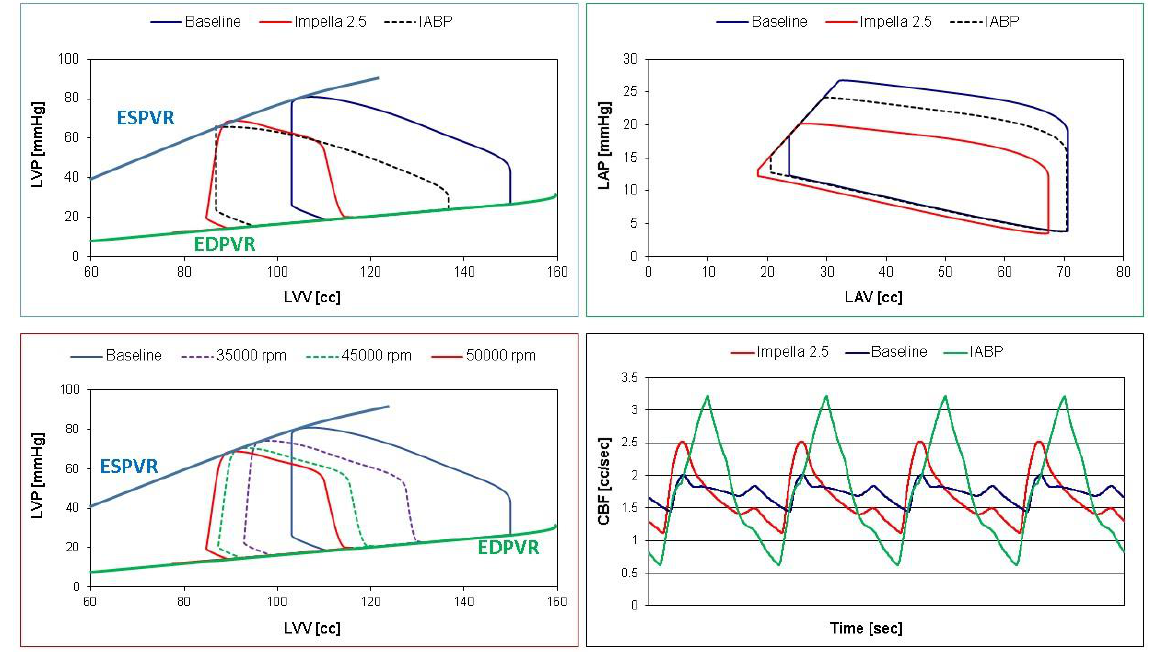
Figure 9. Left ventricular pressure–volume loops ( top and bottom left panels ) and coronary blood flow waveforms ( bottom right panel ) obtained storing data in Excel file and subsequently processed with Excel software. The ( top left (right) panel ) shows the left ventricular (atrial) pressure–volume loops obtained in baseline (blue continuous lines) and assisted conditions with IABP ( Pd = 260 and Pv = − 10 mmHg—dashed black lines) and Impella 2.5 (red lines) at 50,000 rpm. The ( bottom left panel ) shows the left ventricular pressure–volume loops obtained in baseline (blue continuous lines) and assisted conditions with LVAD rotational speed at 35,000, 45,000 and 50,000 rpm.